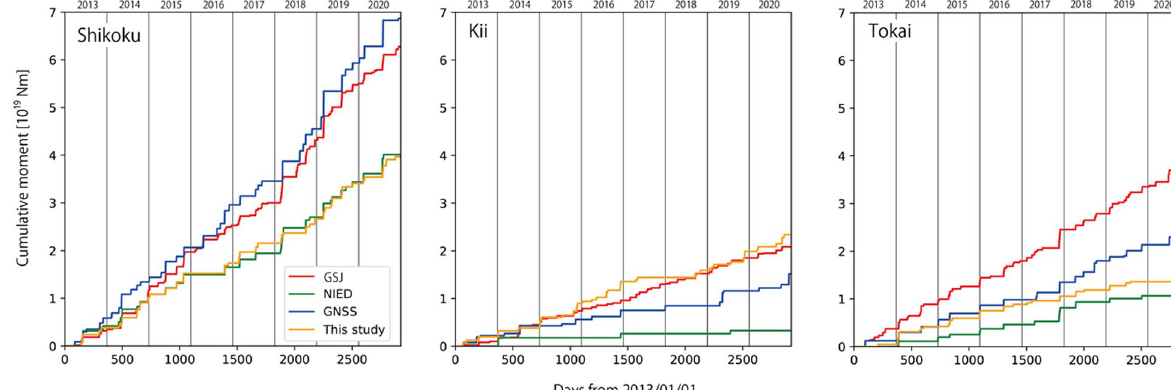
Fig. 11 Time evolution of moment release listed in catalogs. Red, green, blue, and orange lines represent catalogs of the GSJ, NIED, GNSS, and this study, respectively. Three panels show results for the Shikoku regions, Kii region, and Tokai region,